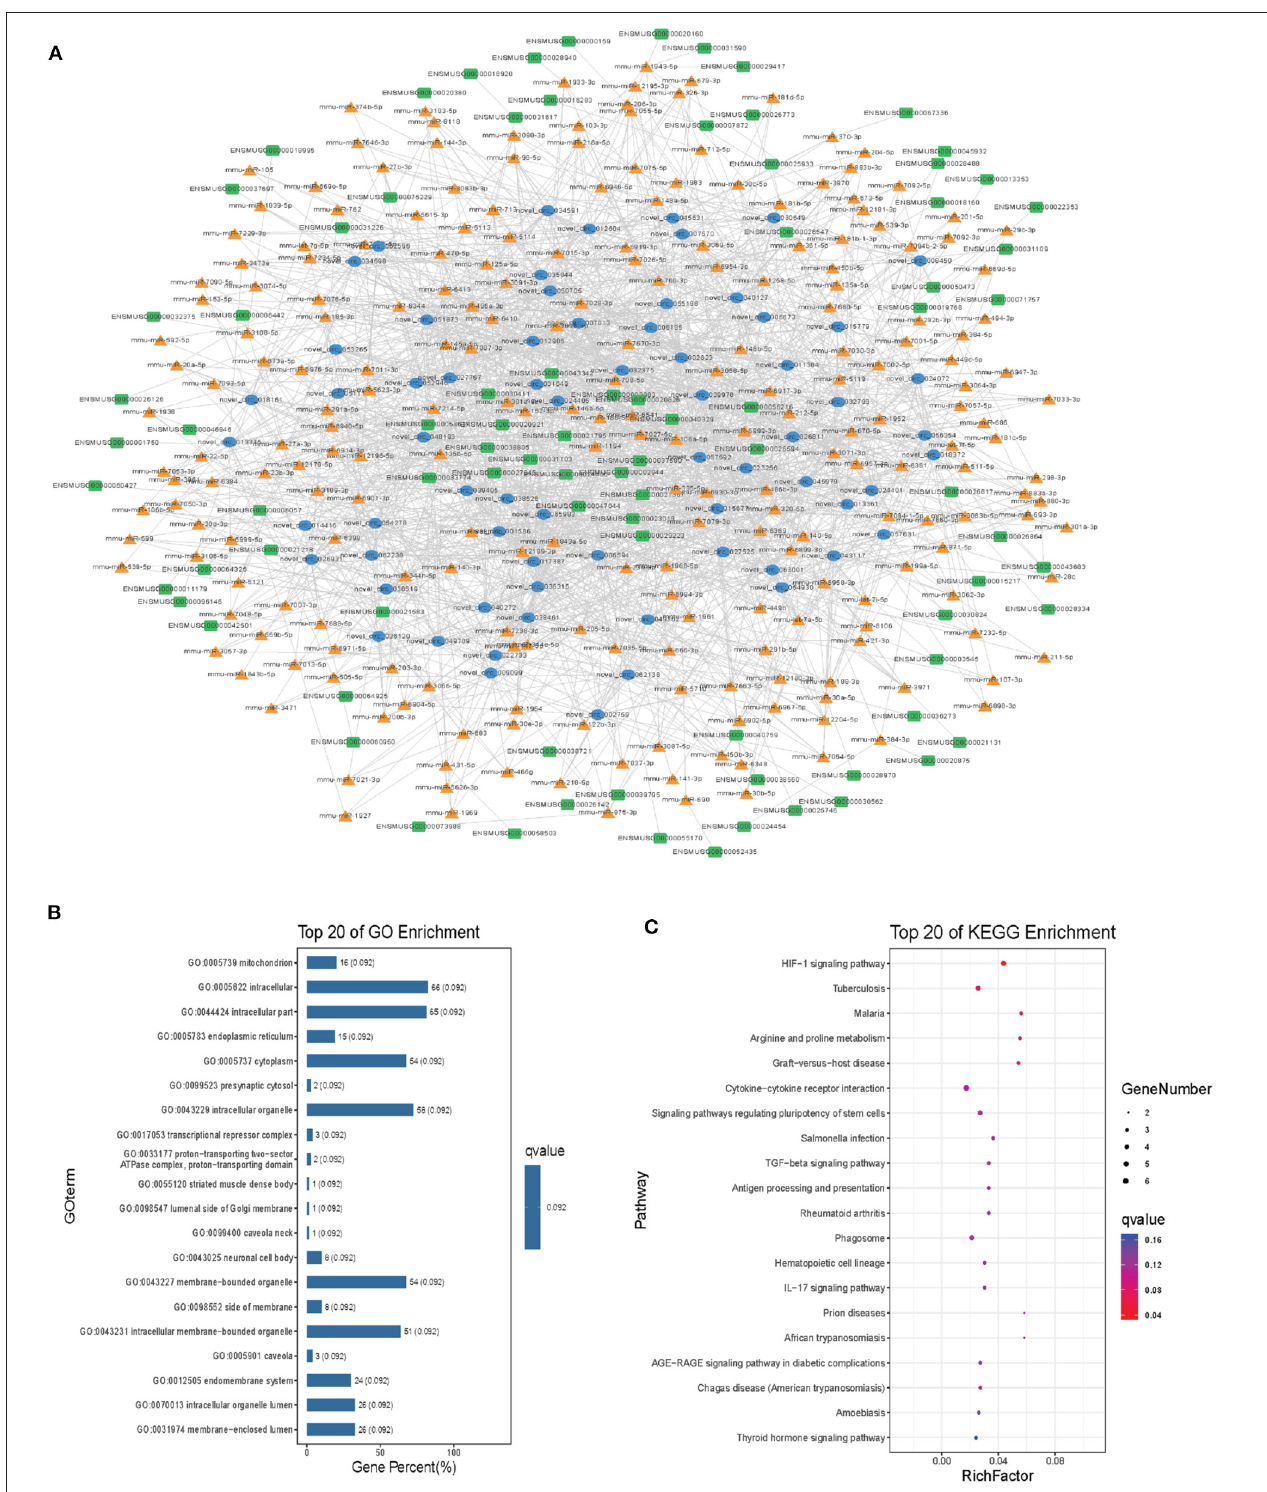
FIGURE 6 | Module 1 from the autism-related ceRNA network. (A) Module 1 network. (B) GO enrichment. (C) KEGG pathway enrichment. Circular blue, triangular orange, and square green nodes represent circRNAs, miRNAs, and mRNAs, respectively.